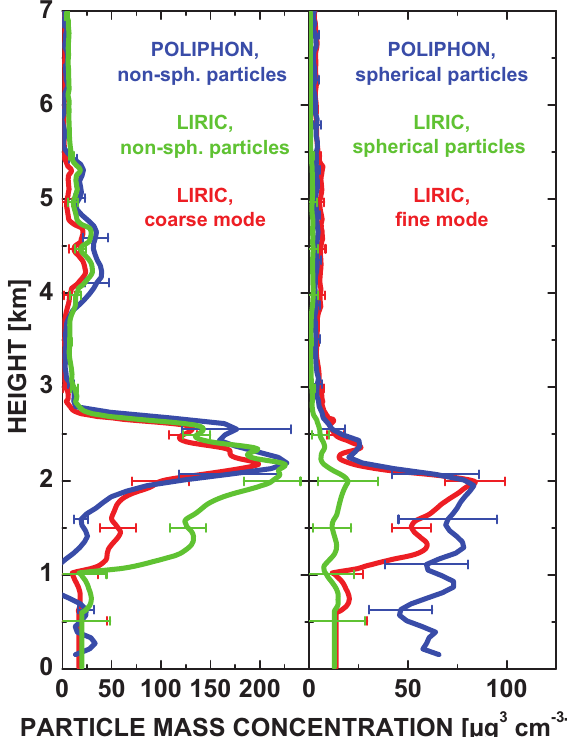
Fig. 11. Same as Fig. 5 except for a volcanic dust observation on 19 April 2010. The POLIPHON curves are taken from Fig. 4 of Ansmann et al. (2012).